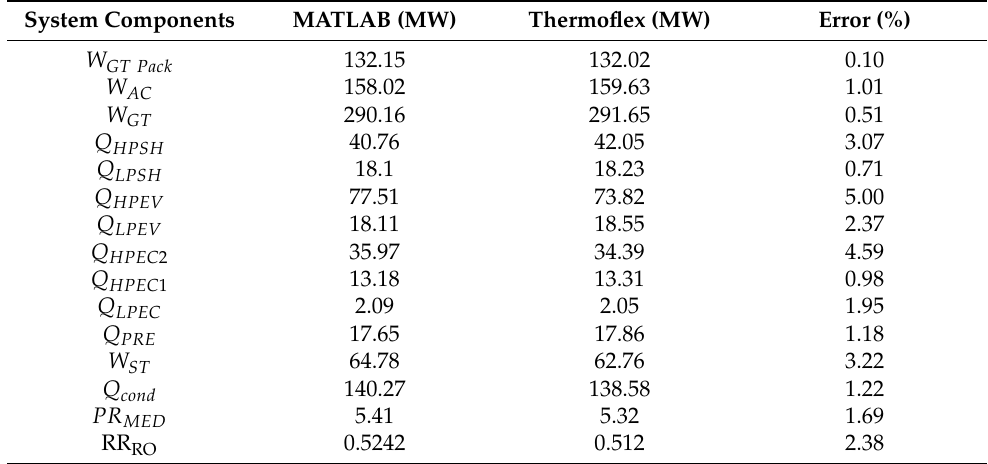
Table A5. Verification of thermodynamic simulation results of the different system components.